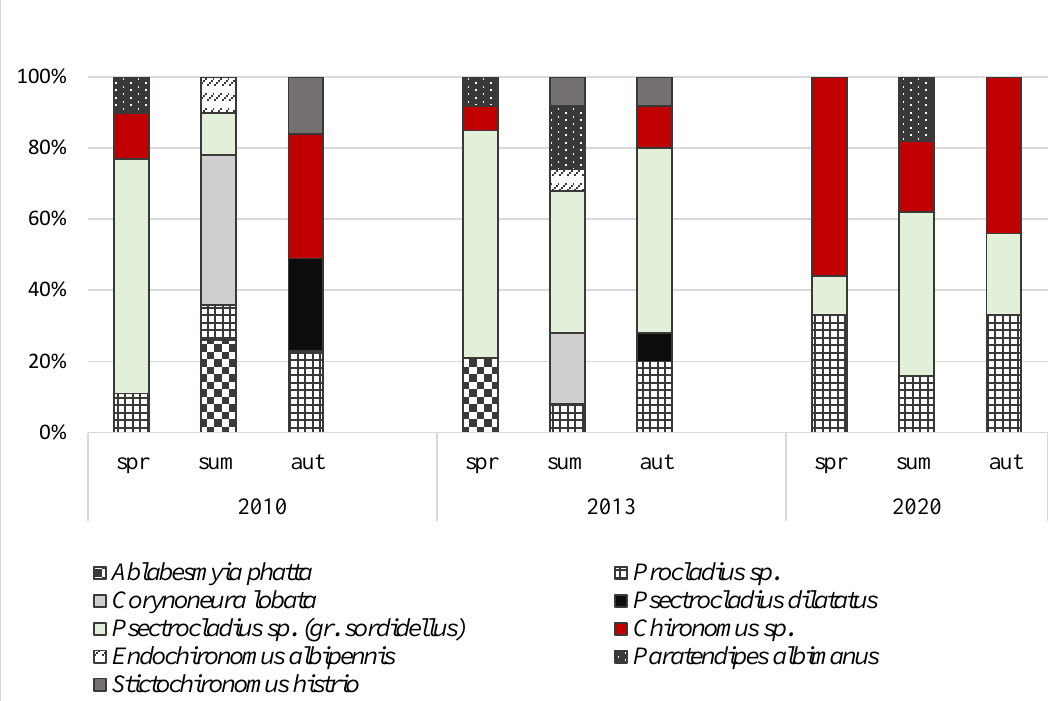
Figure 3. Domination structure of Chironomidae larvae in peat pool habitat during 10 years of study.